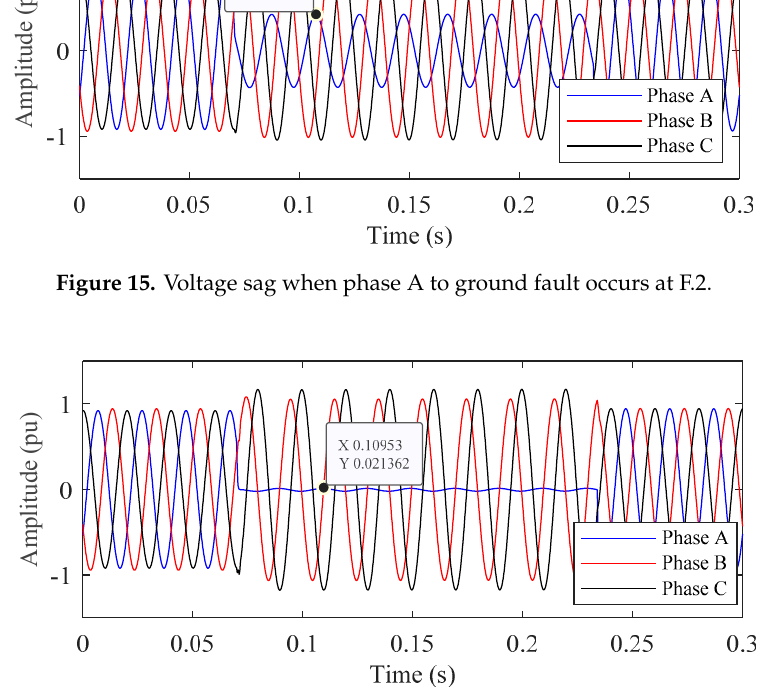
Figure 16. The voltage sag when phase A to ground fault occurs at F.1.